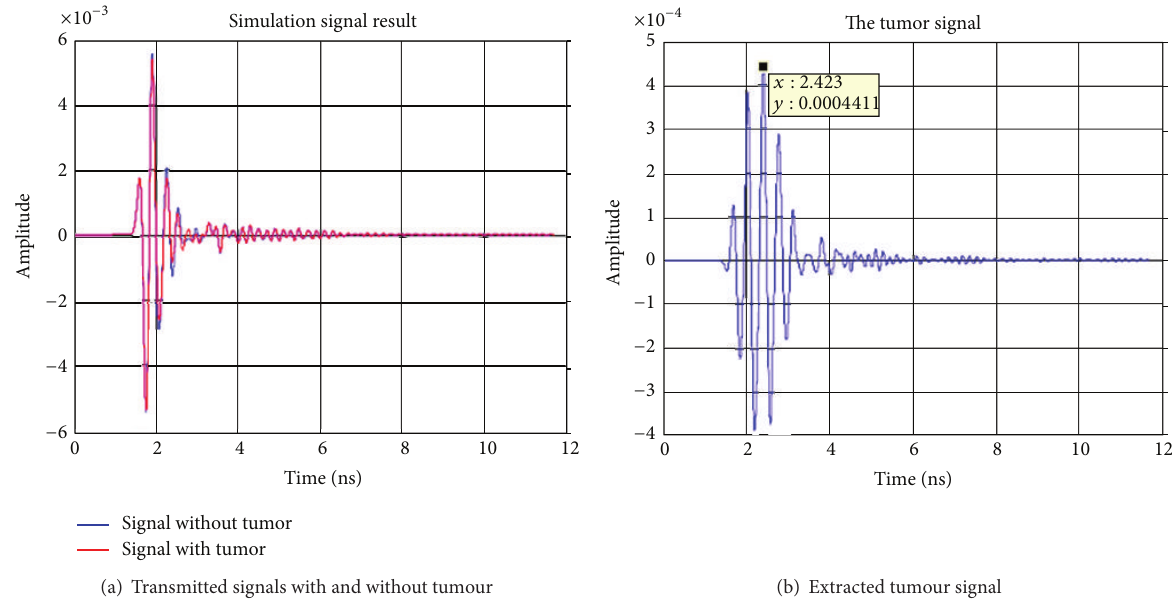
Figure 7: Simulation signal results transmitting from antenna 1 to antenna 4.